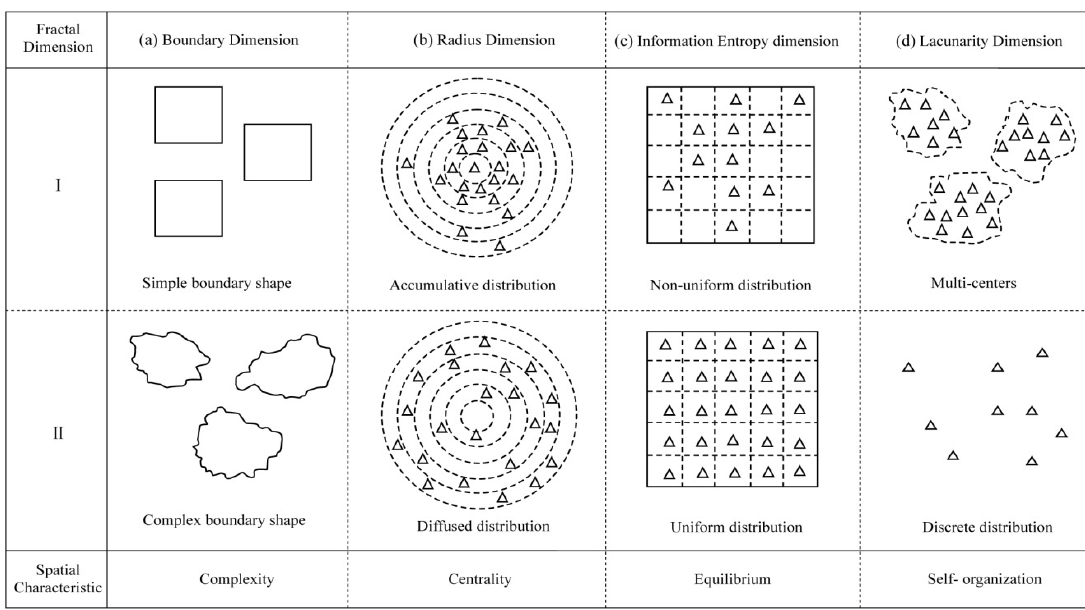
Figure 1. Schematic of the Multidimensional Fractal Model (I and II refer to two opposite patch features or spatial distributions for a given land